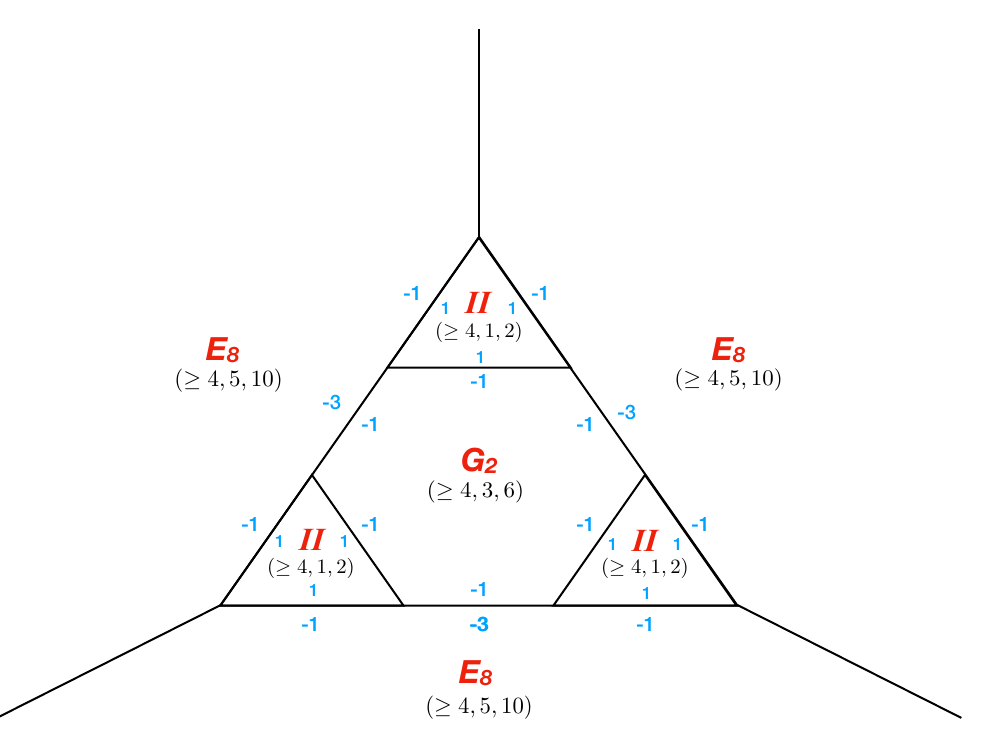
Figure 6 . The initially blown up E 8 { E 8 { E 8 Yukawa